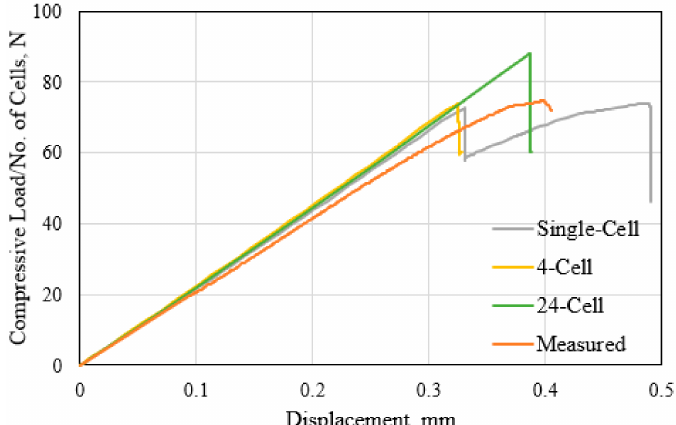
Figure 11. Comparison of the measured and the FE-calculated compressive load–displacement responses for the different FE models of the HC